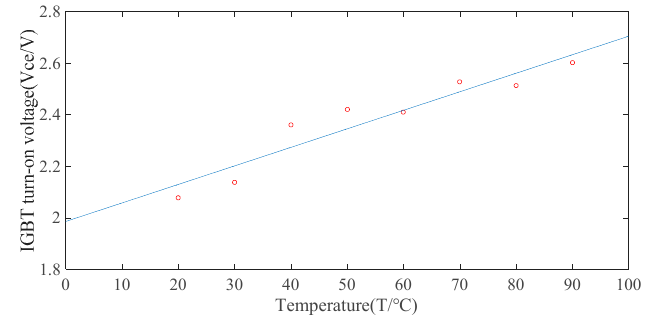
Figure 13. A function fitting diagram of V ce and T .